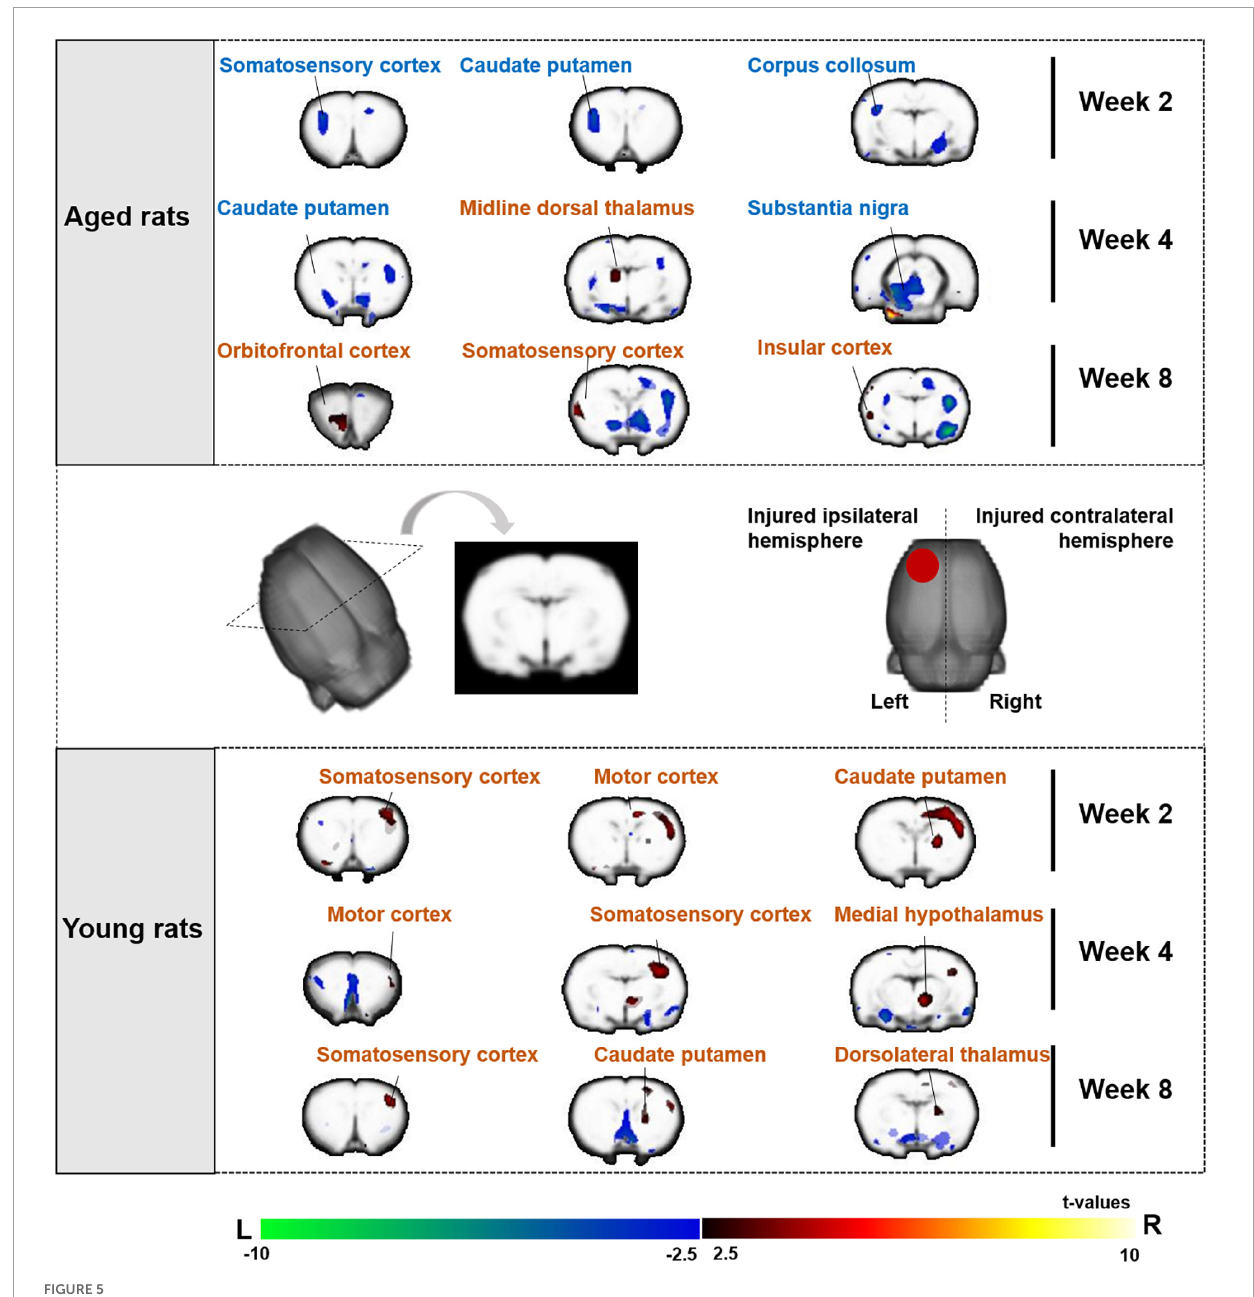
FIGURE5 Sensorimotor brain regions of aged and young rats showing significant differences in metabolic activities on week 2, 4, and 8 after electroacupuncture intervention. The changes of aged rats’ cerebral glucose metabolism after 2, 4, and 8 weeks electroacupuncture were presented in the top of figure, and the changes of young rats were presented in the bottom of figure. The increased metabolism was in the left (the injured ipsilateral hemisphere) sensorimotor brain areas of aged rats during the electroacupuncture intervention, and the increased metabolism was in the right (contralateral to injury hemisphere) sensorimotor brain areas of young rats. The warm color on brain region showed significant higher metabolic activities in the EA/EY group compared with that in the sham EA/EY group, while cold color showed significant lower metabolic activities in the EA/EY group compared with that in the sham EA/EY group. EA group, the aged electroacupuncture group; sham EA group, the aged sham electroacupuncture group; EY group, the young electroacupuncture group; sham EY group, the young sham electroacupuncture group, ( ) red circle on rat brain showed the injured (left) hemisphere, L, left, R, right.